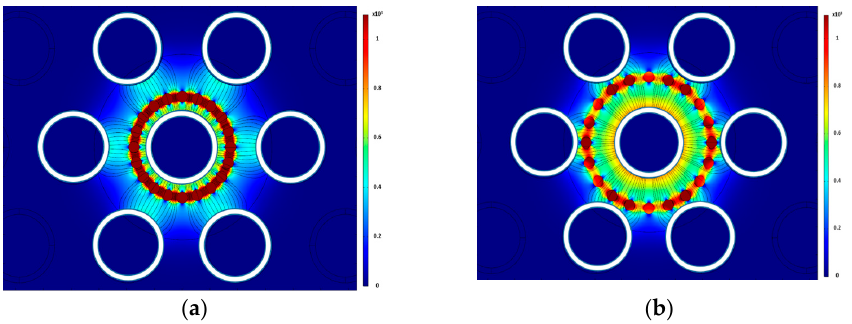
Figure 11. Electric field contour for bubble diameters of ( a ) 7 mm and ( b ) 9 mm.